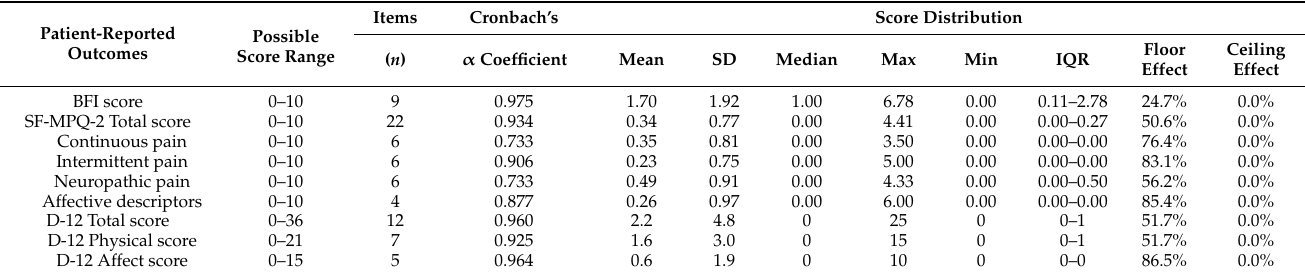
Table 2. The internal consistency and the score distribution in the questionnaires.